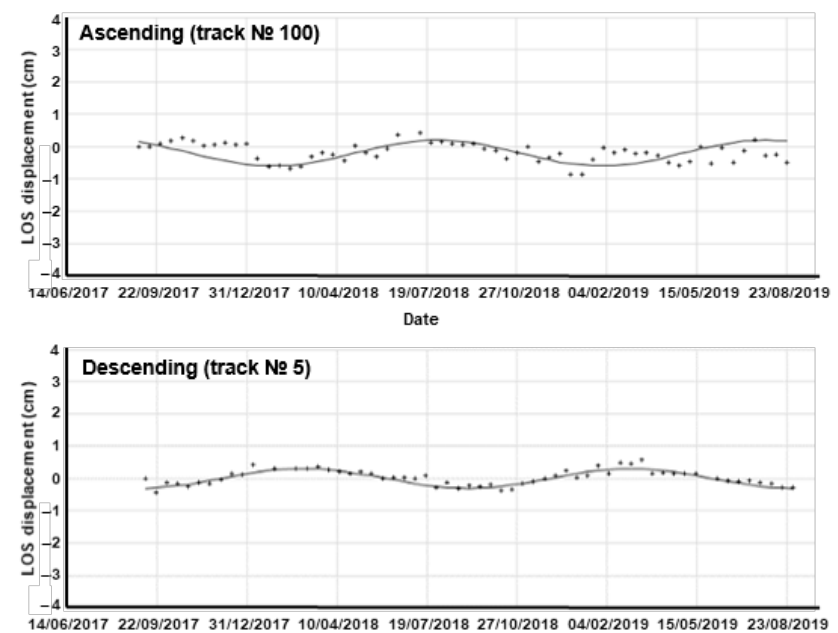
Figure 9. Time-series of ISBAS-derived cumulative LOS ground displacement for point B (indicated in Figure 6), the Usoy Dam.